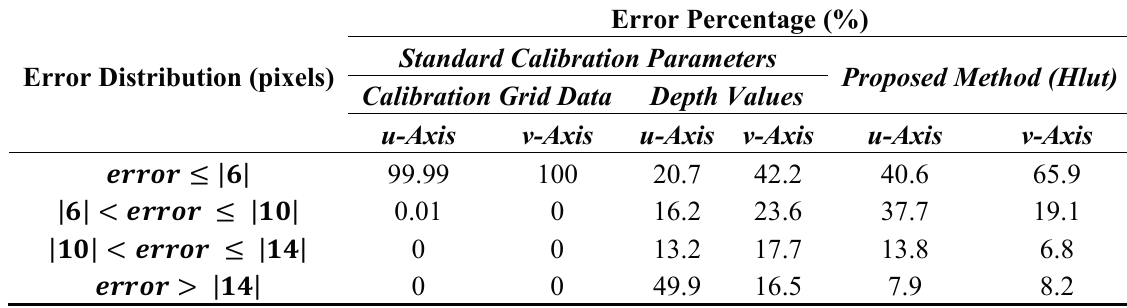
Table 3. Results of the error